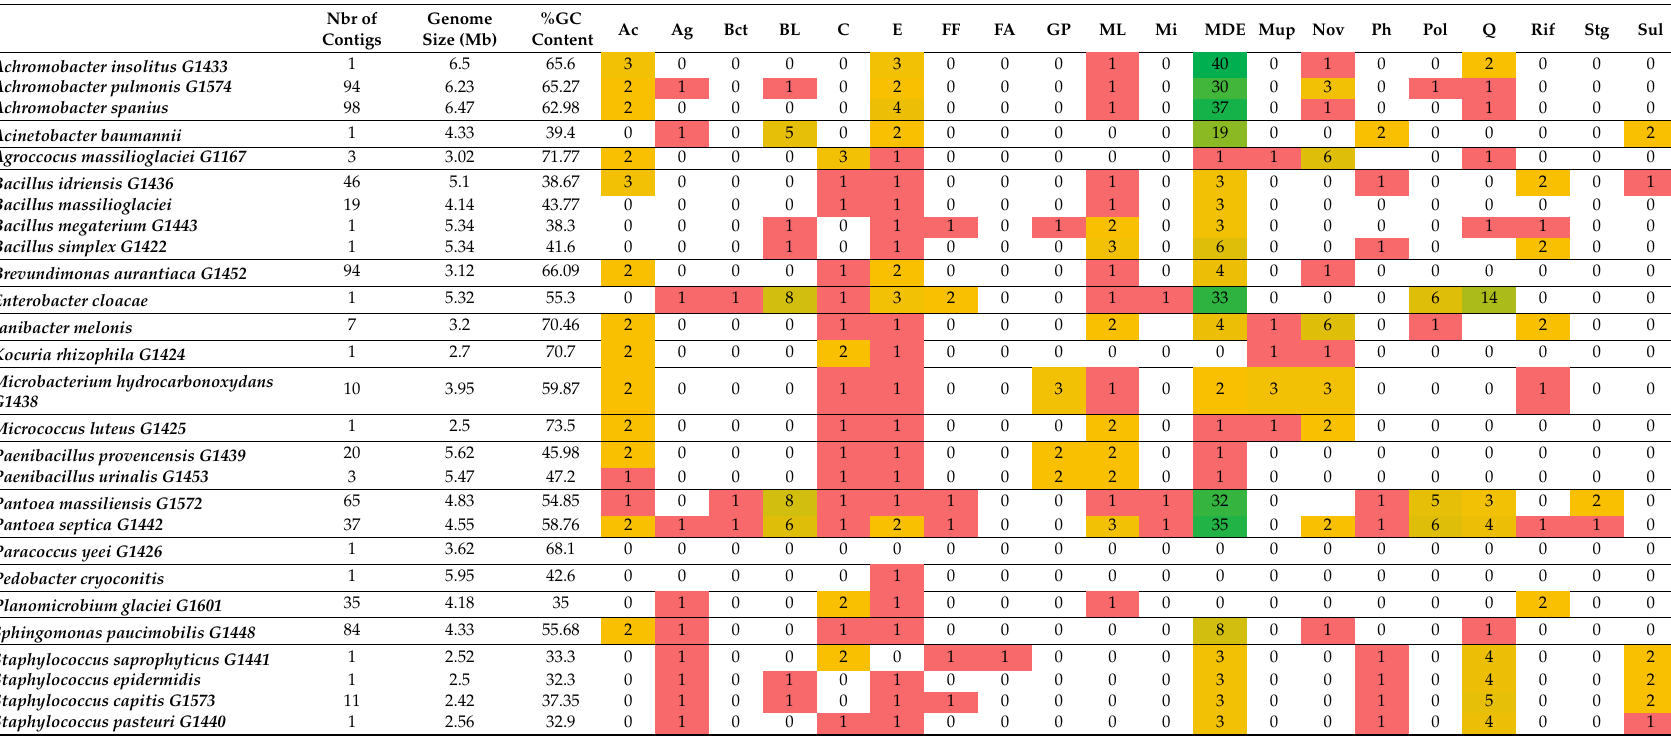
Table 2. Resistome of permafrost strains: BlastP analysis against ARG-ANNOT, CARD and Resfinder Databases. Di ff erent colors mean values refer to the number of antibiotic resistance genes identified by BlastP against three antibiotic resistance gene